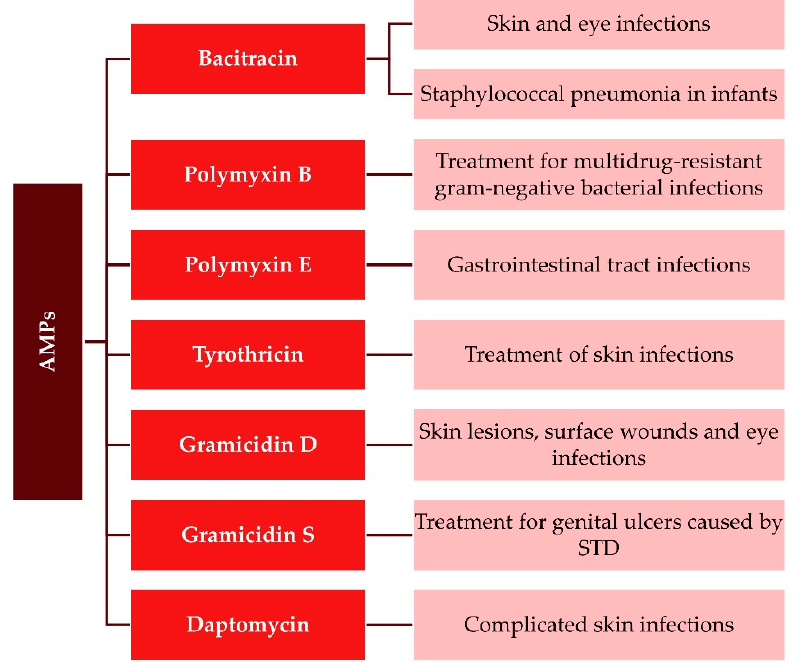
Figure 7. Approved AMPs for use in clinical settings. STD—sexually transmitted diseases. Clinical trials appraising the use of linear AMPs (such as pexiganan, omiganan, and DPK060) against different bacterial and fungal infections are currently underway. As an